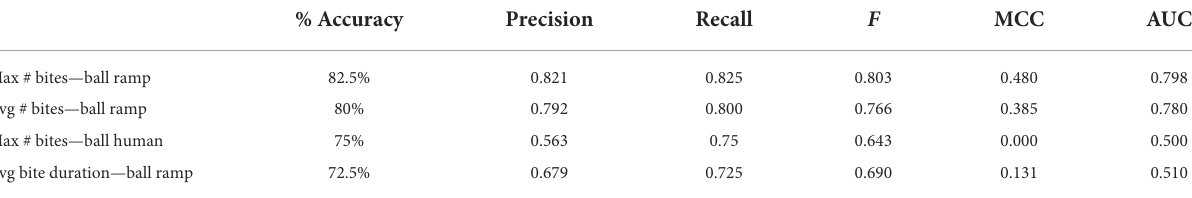
TABLE 5 Individual feature performance metrics in predicting service dog placement (adapted for